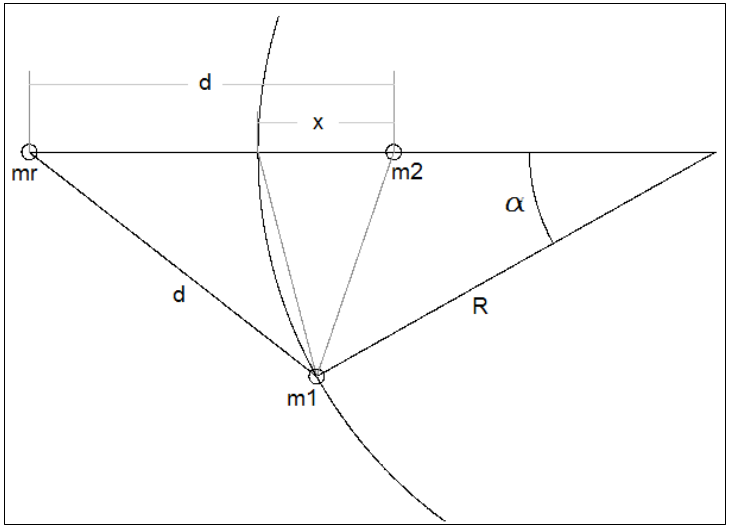
Figure 4. Model parameter in contactless crank-rocker